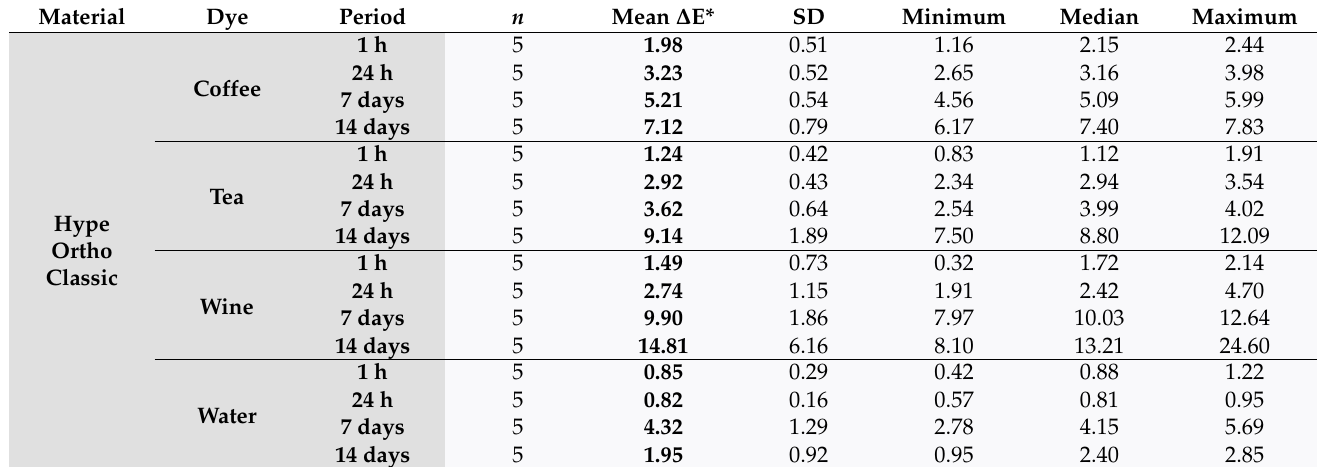
Table 3. Mean color changes of Hype brackets with respect to incubation time and type of dye.